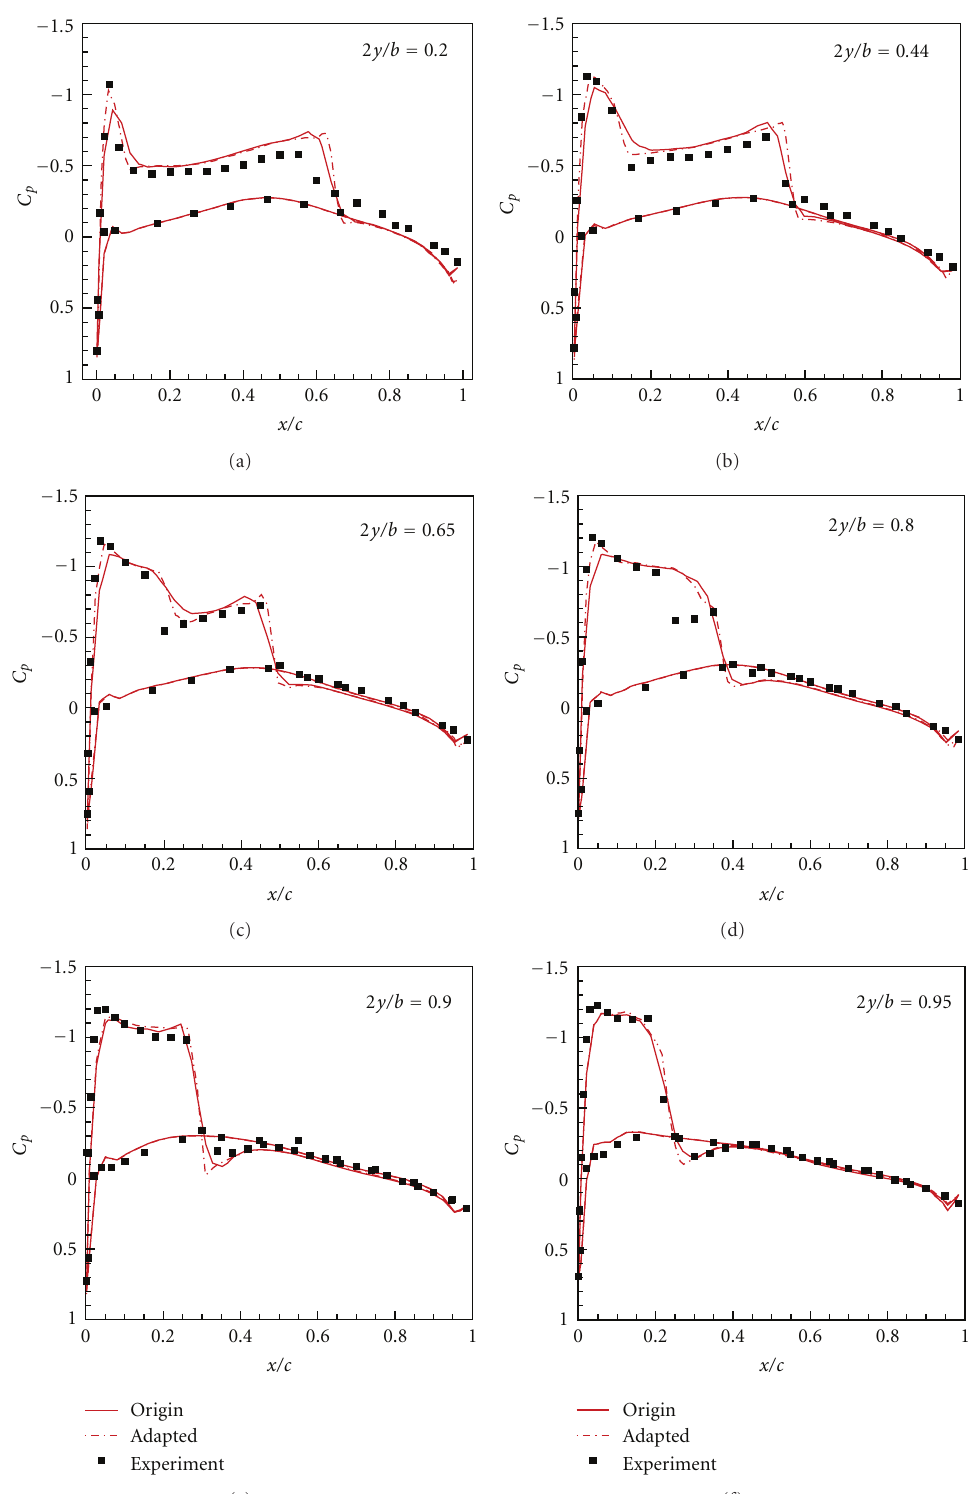
Figure 7: Comparisons of spanwise pressure coe ffi cient distributions for ONERA M6 wing between before and after